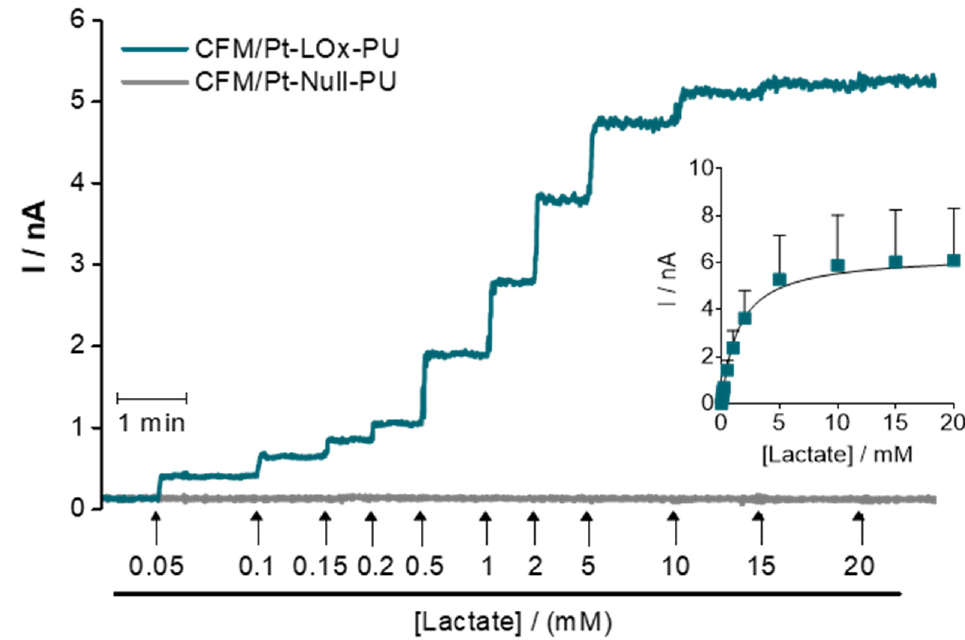
Figure 2. Enzyme kinetics of the CFM/Pt-LOx-PU biosensor. Representative recording showing the response of the CFM/Pt-LOx-PU (blue) and CFM/Pt-Null-PU (grey) sensors to increasing lactate concentrations (up to 20 mM). The addition points and the final concentration of lactate following each addition are indicated by arrows. Inset: Data (current as a function of lactate concentration) was fitted to the Michaelis-Menten equation. Values represent mean ± SEM ( n = 8). Table 1. Kinetic and analytical parameters of CFM/Pt-LOx-PU and CFM/Pt-LOx-PU-PD microbio- sensors.